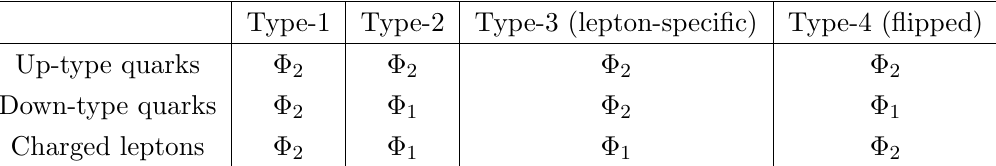
Table 1 . Doublets to which the di(cid:11)erent types of fermions couple in the four types of 2HDM without FCNC at lowest order.